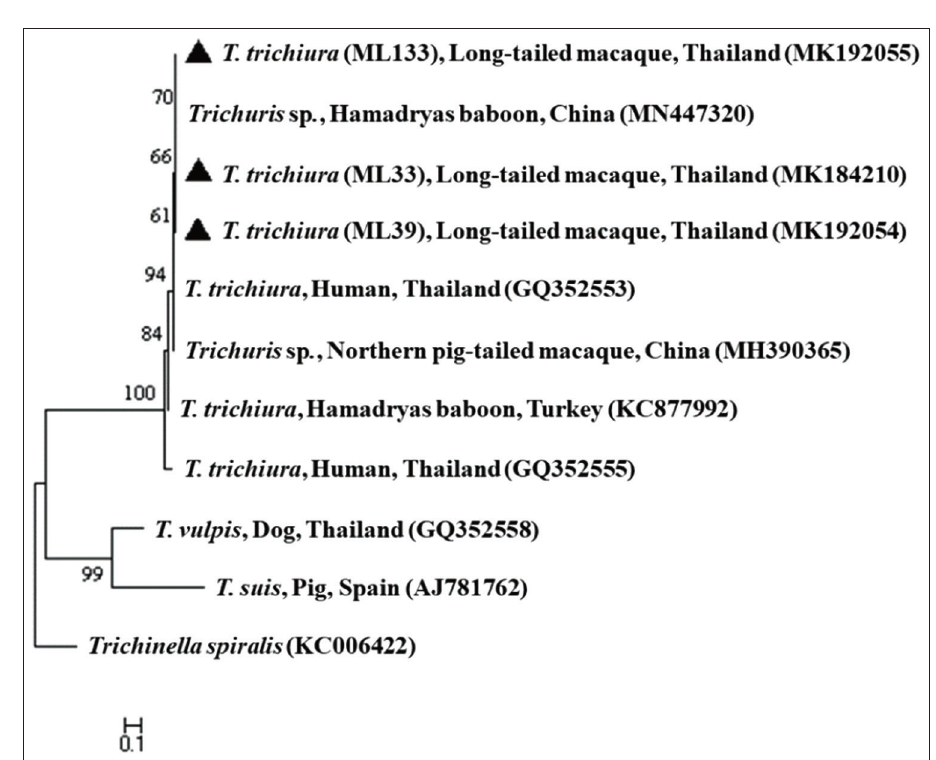
Figure-1: Phylogenetic tree based on internal transcribed spacer region 1 sequences of Trichuris trichiura based on the maximum likelihood method. Bootstrap percentages are shown at nodes. Trichinella spiralis is the outgroup. Isolates obtained in the current study are coded using triangular